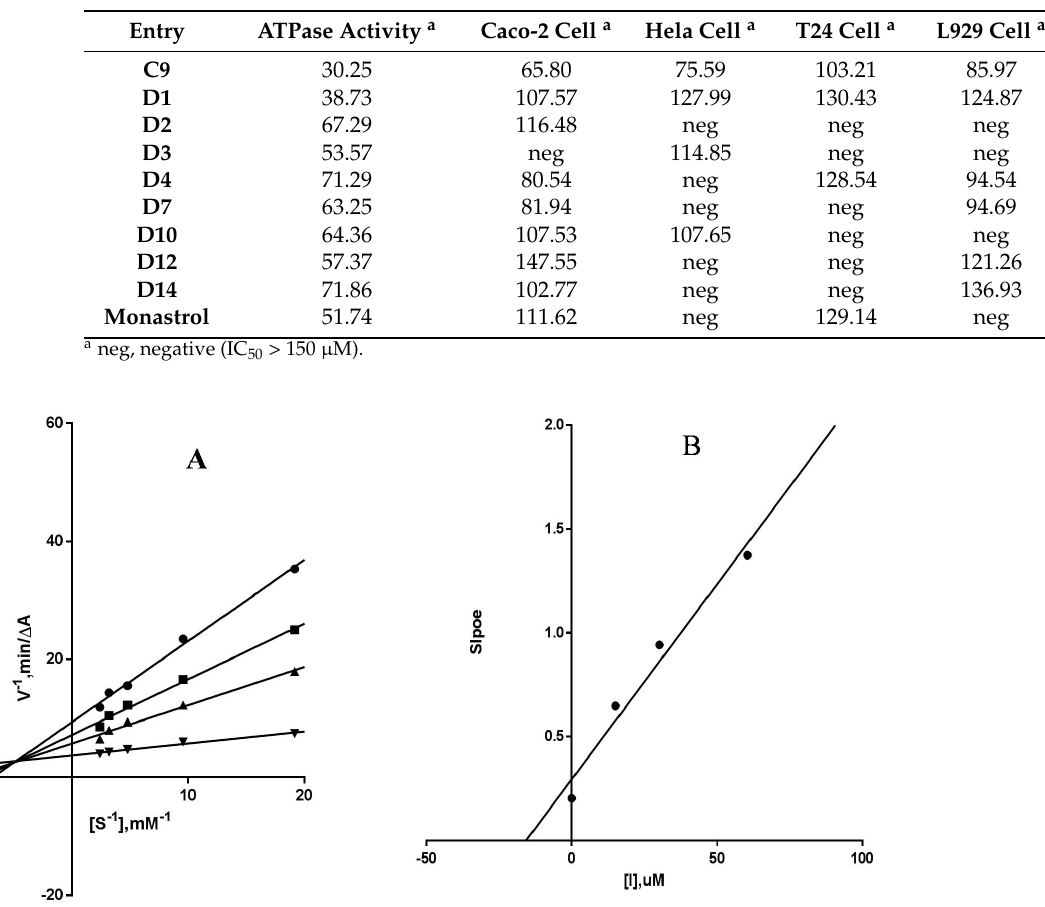
Table 3. IC 50 values for inhibition of microtubule-stimulated KSP ATPase activity and mitotic arrest in cell-based assays for compounds.